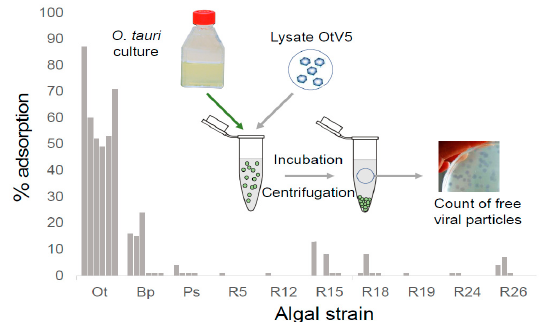
Figure 6. Acquired resistance reduces adsorption of OtV5. Ten algal strains (abscissa) were each assayed six times (grey bars) for their ability to bind to OtV5. Ot : control susceptible wild-type O. tauri RCC4221, Ps : Picochlorum sp. RCC4223 , Bp : Bathycoccus sp. RCC4222, R : OtV5-resistant line [19].